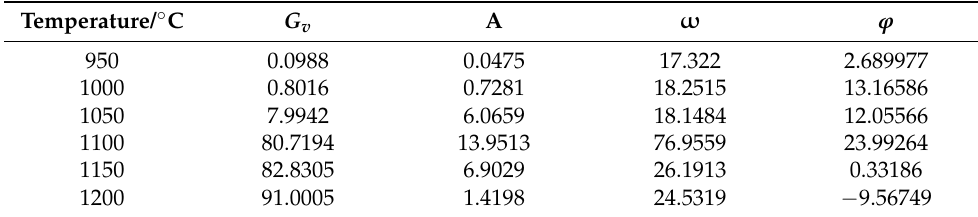
Table 3. Parameters of arsenic vaporization